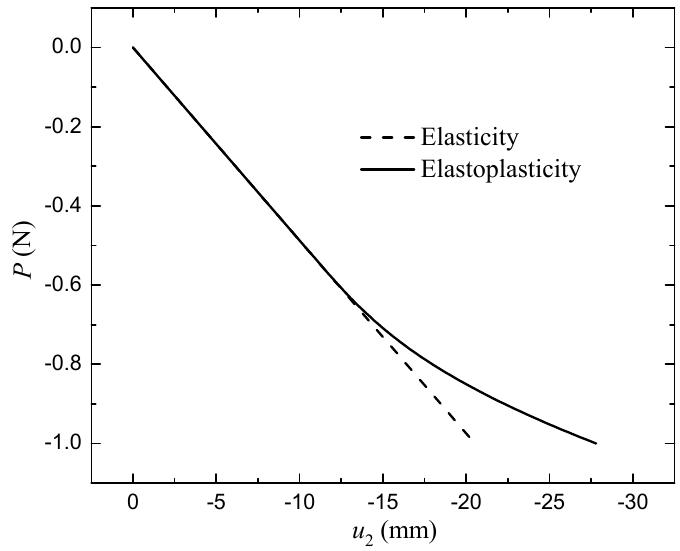
Figure 7. The relation between the load and the deflection.